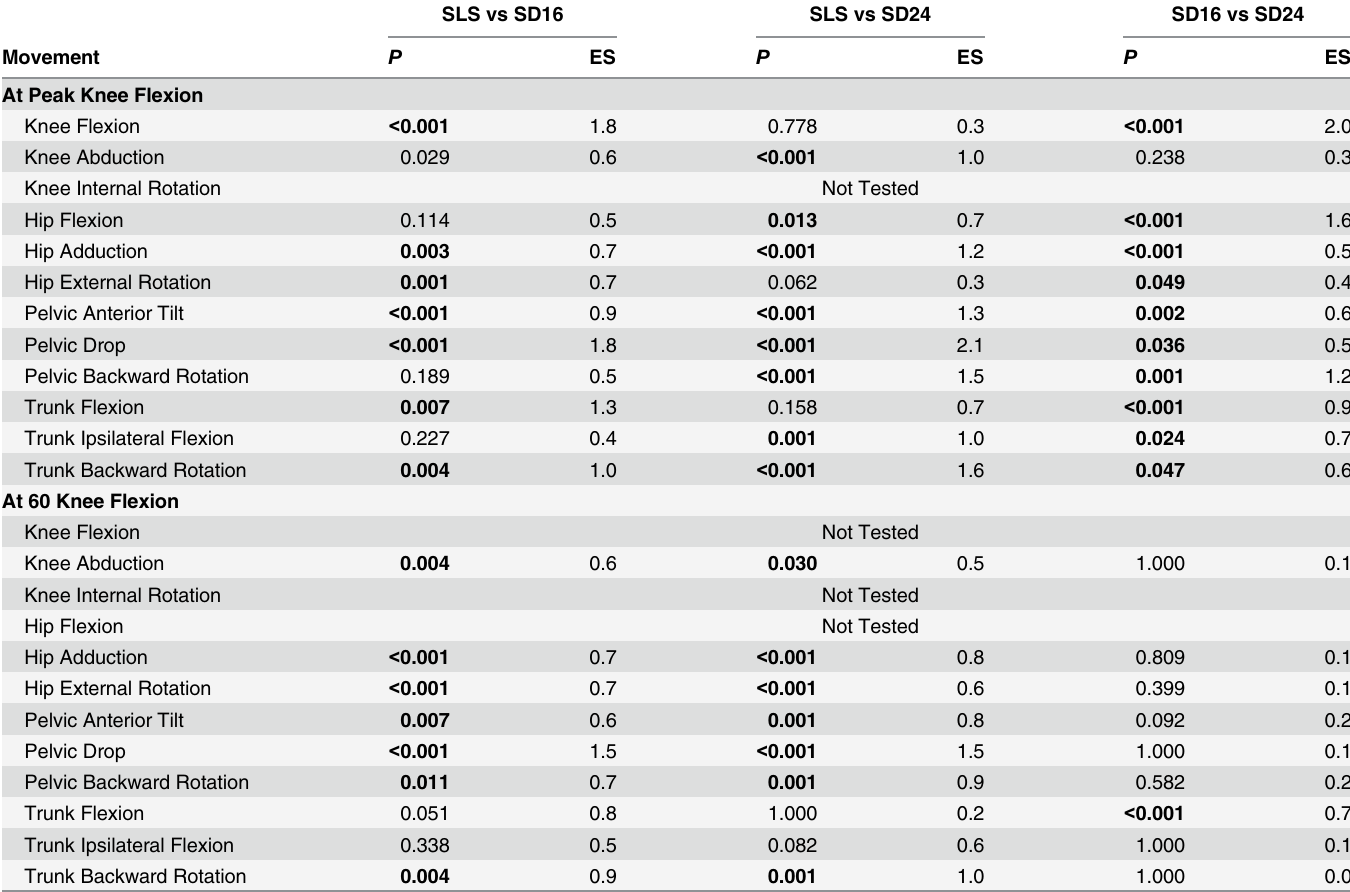
Table 2. Results of post-hoc tests and effect size (ES) for each variable for each comparison at the two time points are presented with bold text in- dicating significance.